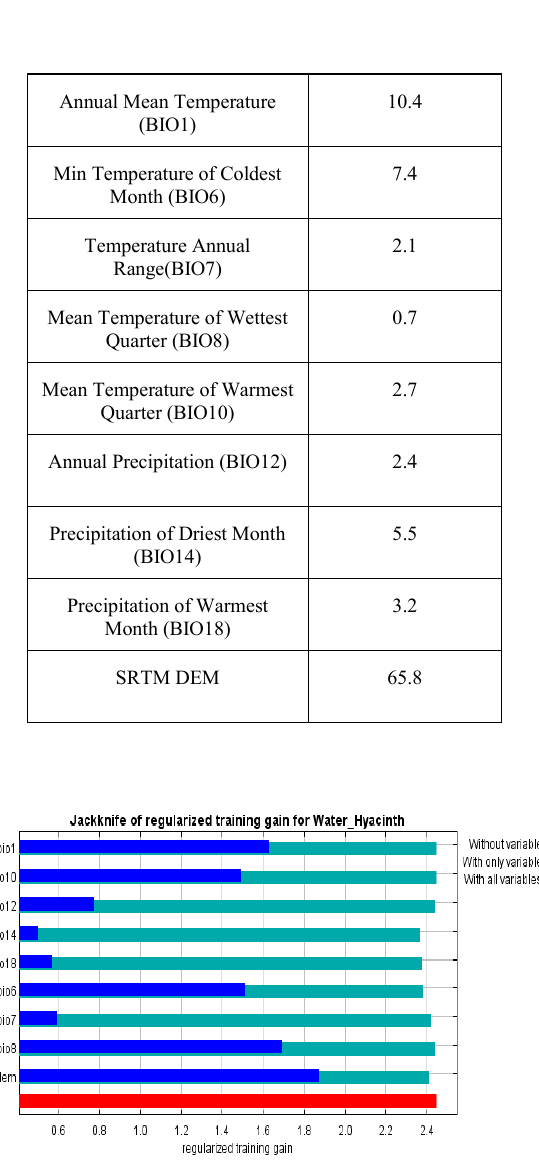
Figure 5. Jackknife of regularized training gain for Water